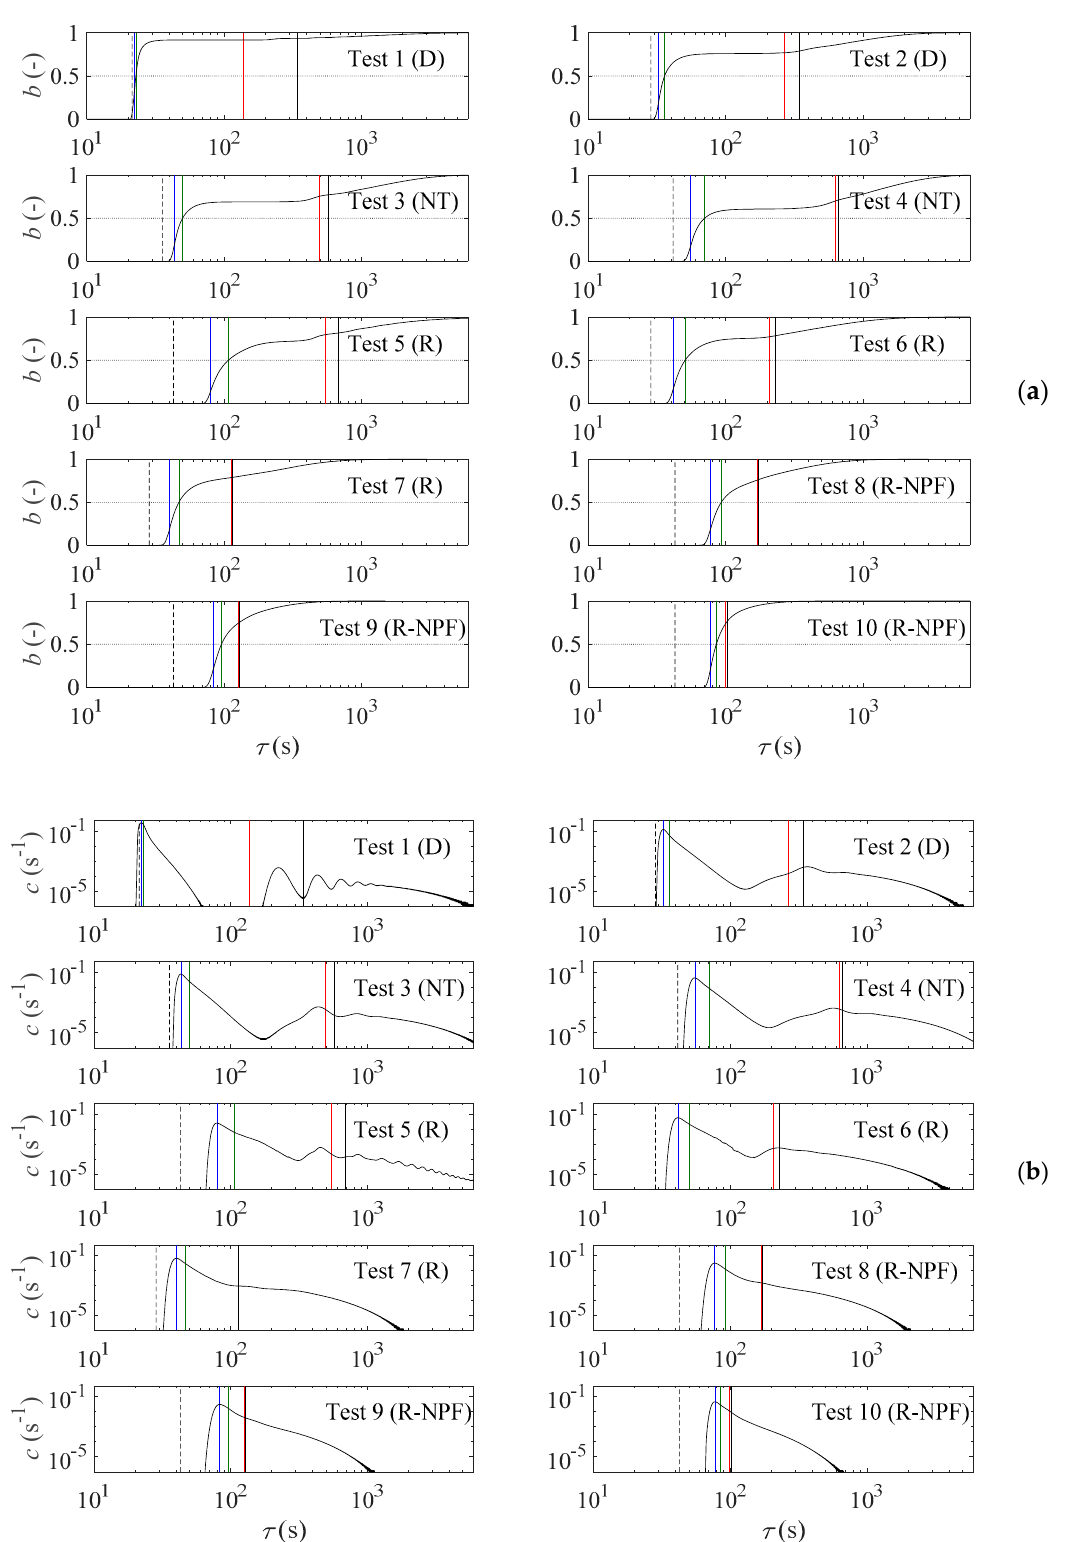
Figure 4. Water age distribution at the reservoir outlet in all configurations: ( a ) cumulated distributions b and ( b ) distributions c . Abbreviations “D”, “NT”, “R” and “R-NPF” refer respectively to detached jet, near-transition, reattached and reattached with nearly-plug-flow. The blue ( − ), green ( − ) and red ( − ) vertical lines ( − ) show the mode, median and mean of the age distribution, respectively. The plain ( − ) and dashed (–) black vertical lines represent the characteristic times V / Q and L / ( Q / S in ), respectively.